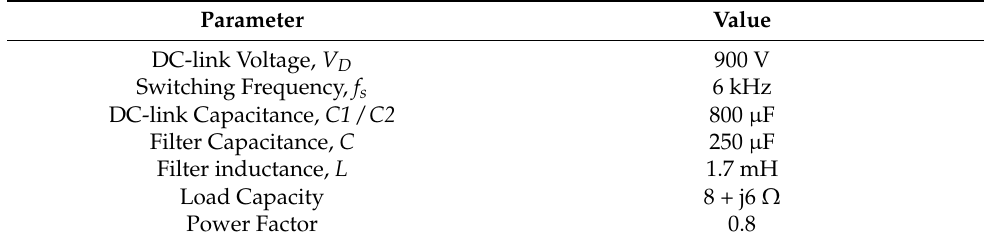
Table 5. Voltage eigenvector change after fault propagation.